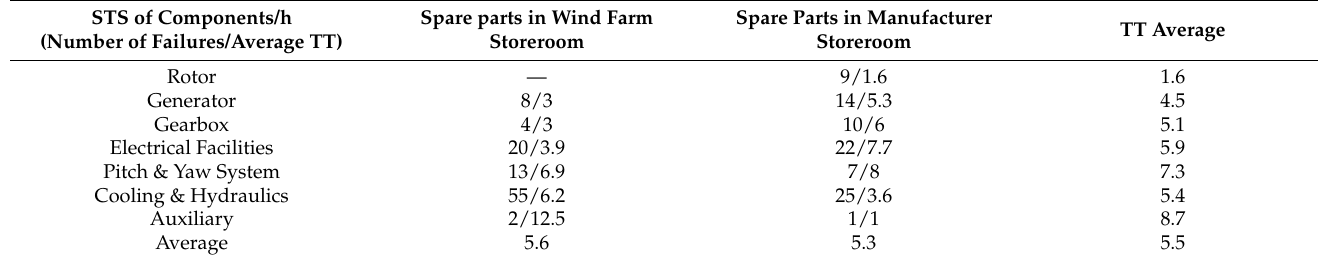
Table 10. Travelling times of maintenance to components, sorted by storeroom/hours.